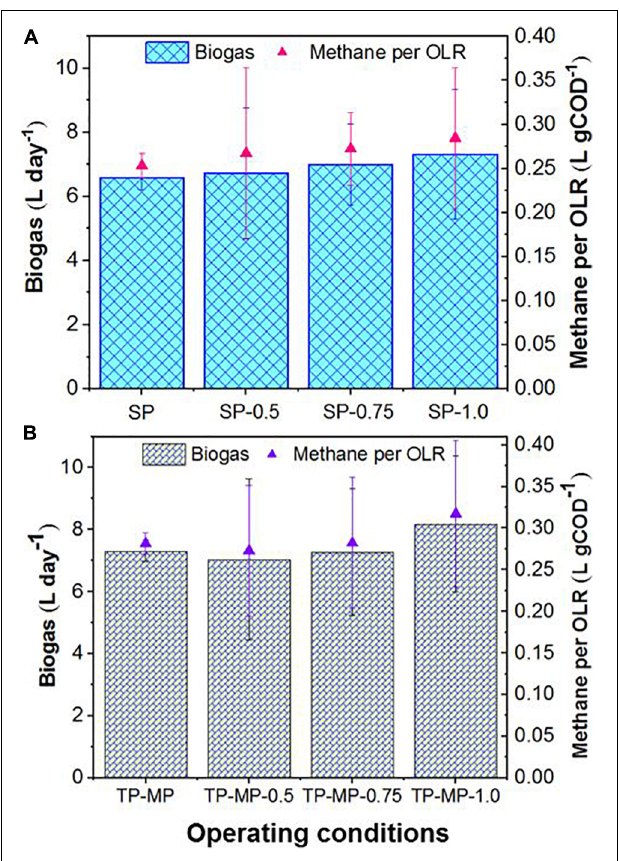
FIGURE 1 | Biogas production rate and methane per OLR in single-phase (A) and two-phase (B) AnMBRs during mono and co-digestion of food waste and FOG. The number after SP and TP-MP shows the fat loading for each system. For example, TP-MP-0.5 means TP-MP AnMBR treatment at 0.5 kg m − 3 day − 1 fat loading. No number after SP and TP-MP means no fat addition with food waste (i.e.,